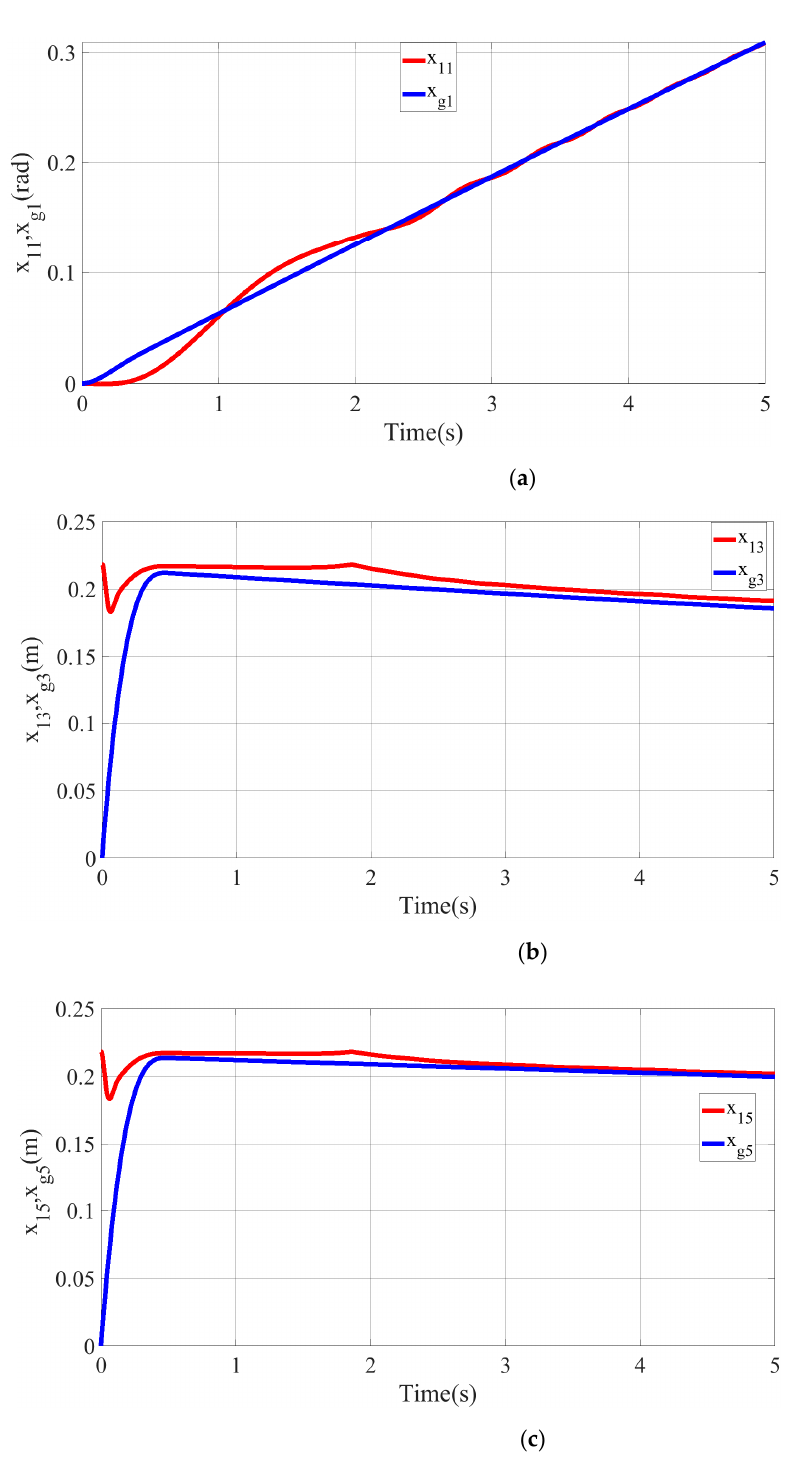
Figure 12. Iterative convergence curve of each joint ‐ position tracking. ( a ) The joint ‐ angle tracking curve of the SCARA manipulator. ( b ) Position ‐ tracking curve of PMA1. ( c ) Position ‐ tracking curve of PMA3.